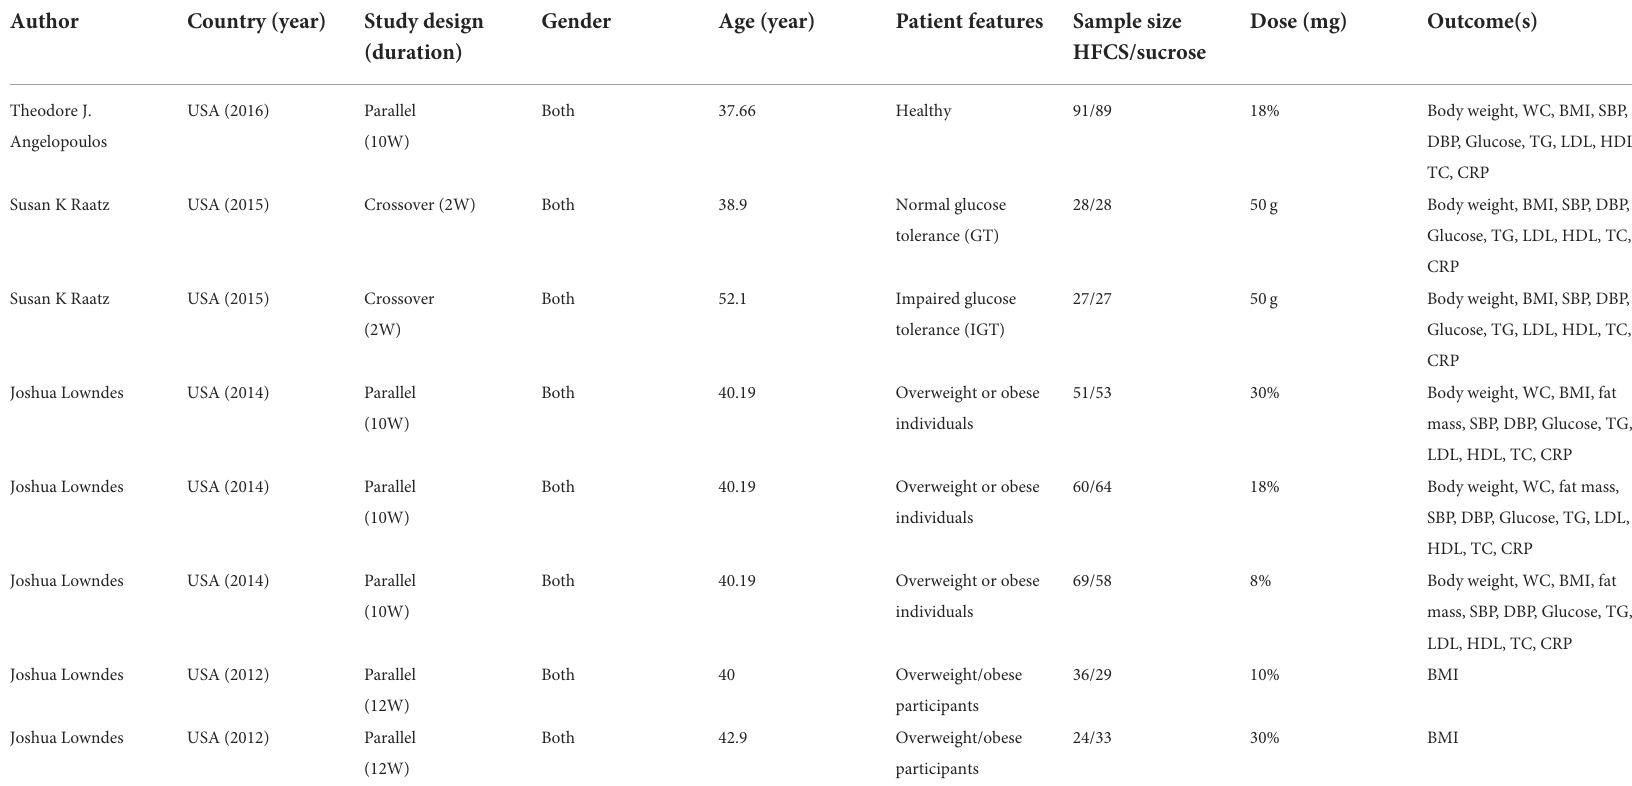
TABLE 1 Characteristics of included